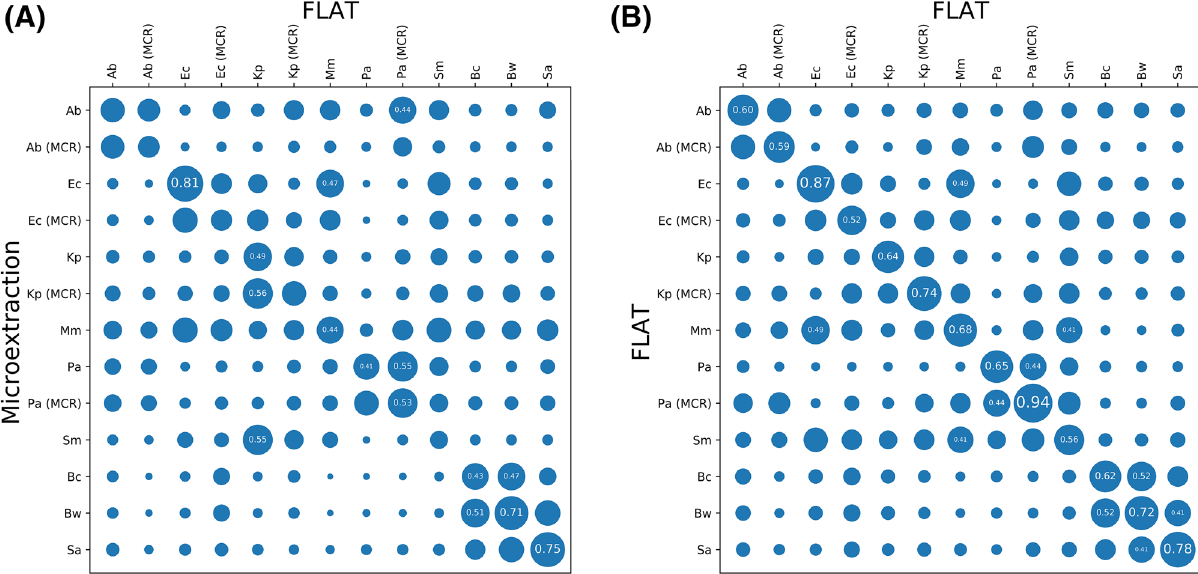
Figure 4. FLAT spectra are distinctive by bacterial species and similar to equivalent Microextraction spectra. ( A ) A heatmap demonstrating that FLAT produces spectra consistent with microextraction. ( B ) A heatmap demonstrating FLAT species and mcr-1 status differentiation. In both cases, similarity between two groups of spectra was computed via the mean cosine similarity across all pairs of spectra, and is visualized as a circle with a proportionally scaled diameter. A total of 149 FLAT spectra and 148 microextraction spectra were used in this comparison, from strains and samples as described in Supplementary Tables S1 and S2 online. CR: mcr-1 transformed; Ab: Acinetobacter baumannii; Ec: Escherichia coli; Kp: Klebsiella pneumoniae Pa: Pseudomonas aeruginosa; Mm: Morganella morganii; Sm: Serratia marcescens; Bc: Bacillus cereus; Bw: Bacillus